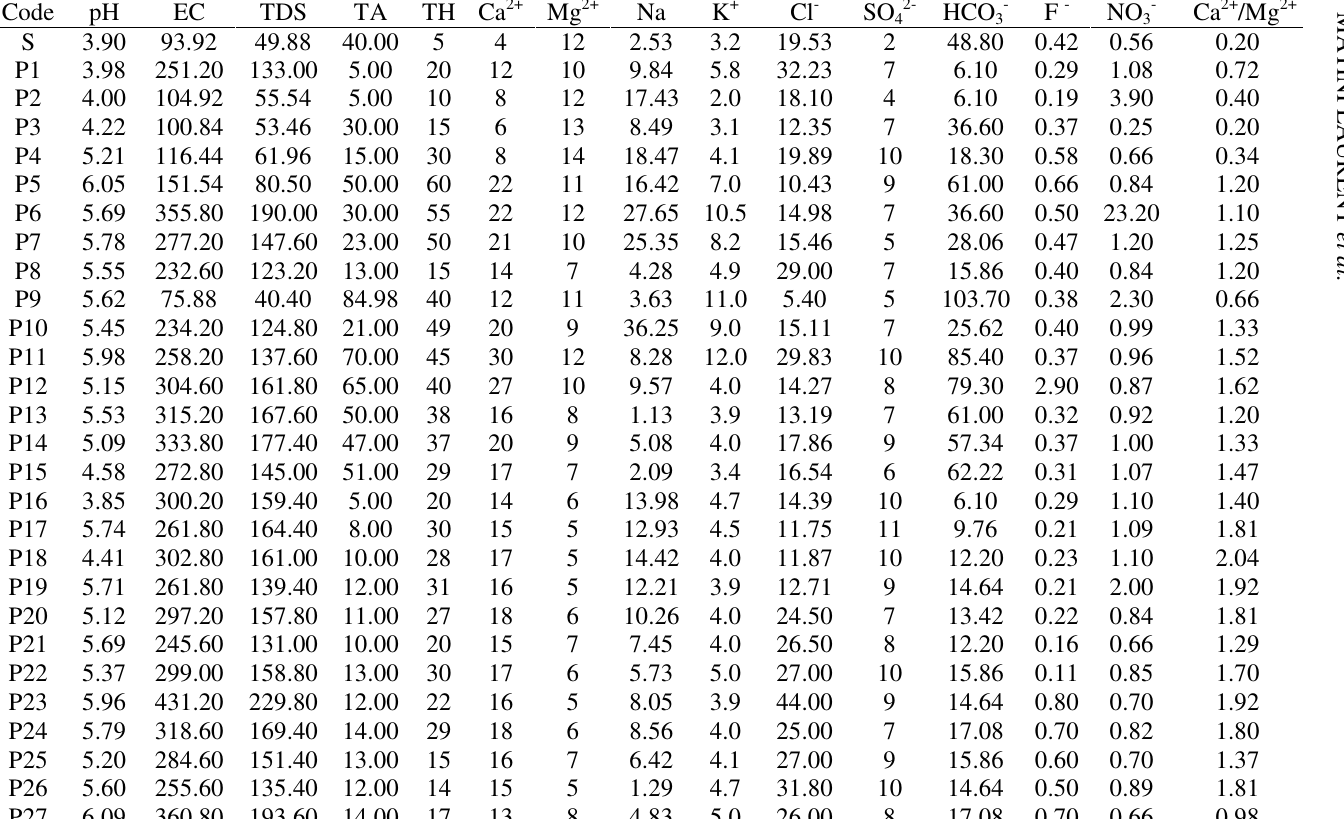
Table 1 . Hydrochemical parameters of groundwaters in the study